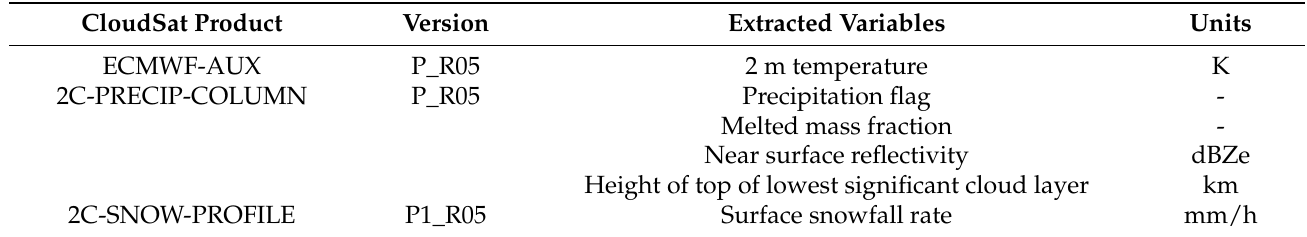
Table 1. CloudSat data products and extracted variables used in this